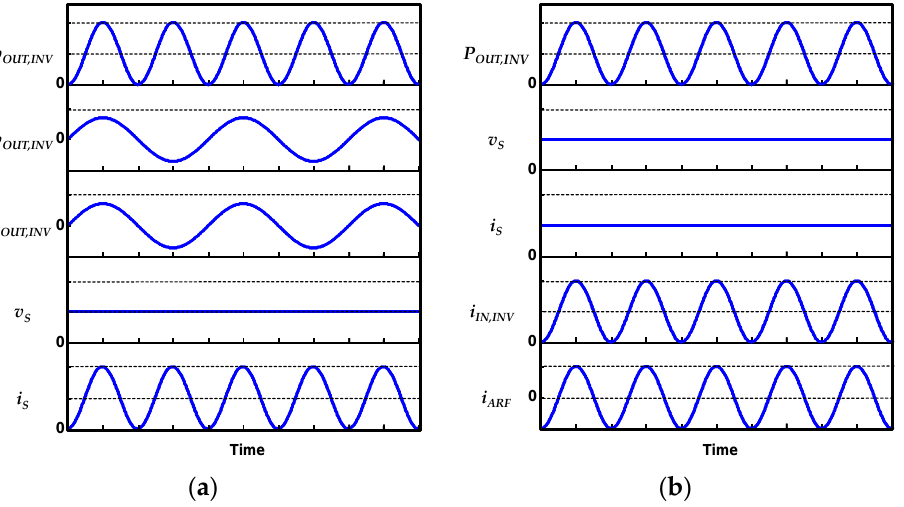
Figure 2. Integration of the ARF into a single-phase DC/AC conversion system [26].